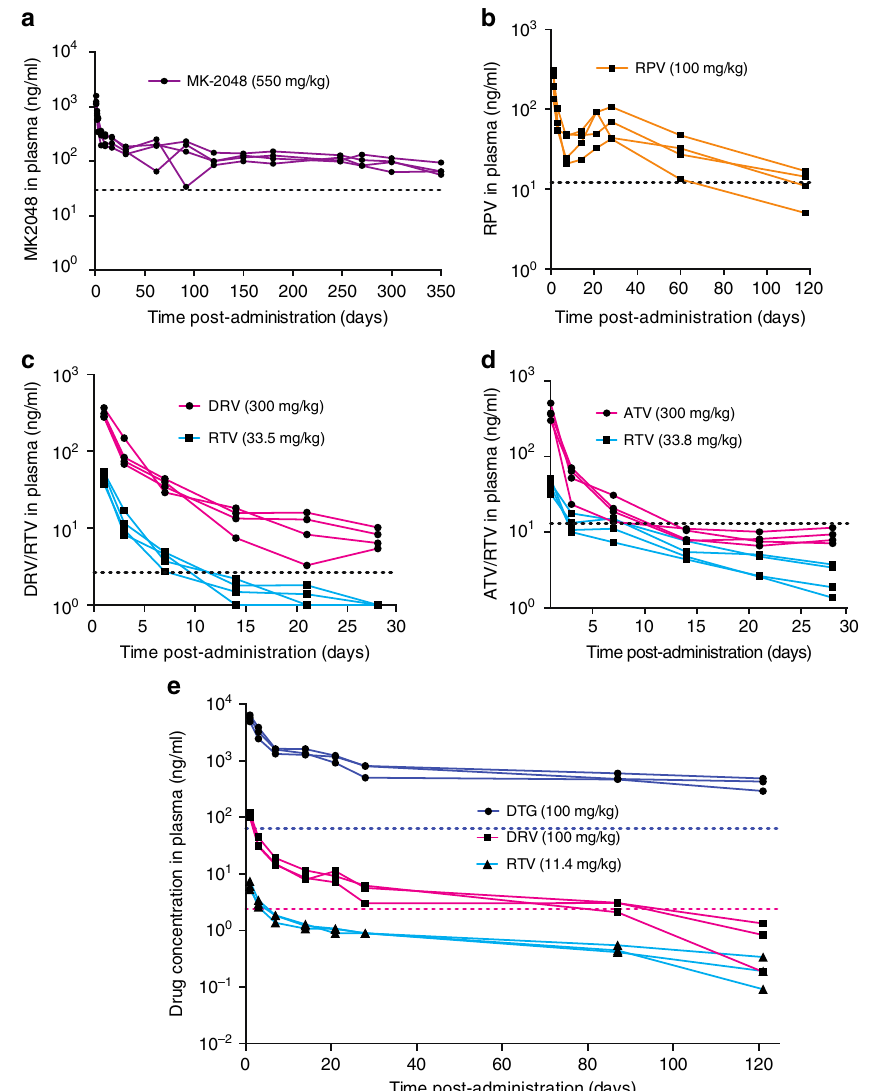
Fig. 8 In vivo release of various ARVs formulated individually or in combination. Indicated dose of antiretrovirals formulated individually ( a , b ) or in combination ( c – e ) as ISFI was injected subcutaneously into NSG mice and plasma concentrations were analyzed longitudinally. Plasma concentrations for each individual mouse are shown. a MK2048, n = 4. b Rilpivirine (RPV), n = 4. c Co-formulated darunavir (DRV) and ritonavir (RTV), n = 4. d Co- formulated atazanavir (ATV) and ritonavir (RTV), n = 4. e Co-formulated dolutegravir (DTG), darunavir (DRV) and ritonavir (RTV), n = 3 PA-IC90 of drugs in ISFIs are indicated with dotted lines in each panel and correspond to the following values: MK-2048 33 ng/ml ( a ), rilpivirine 12 ng/ml ( b